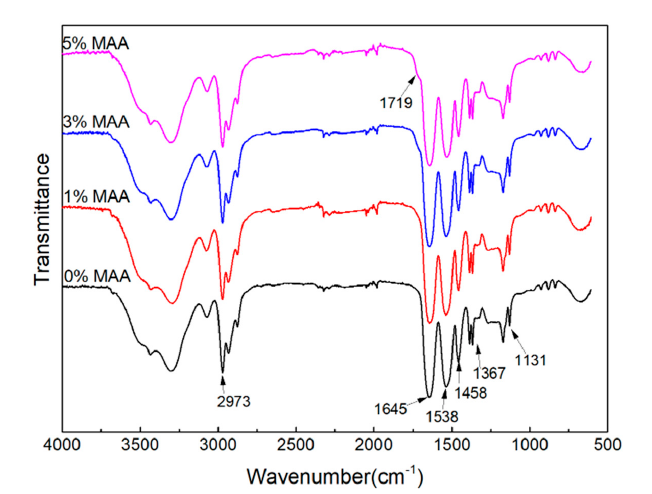
ff erent MAA contents.